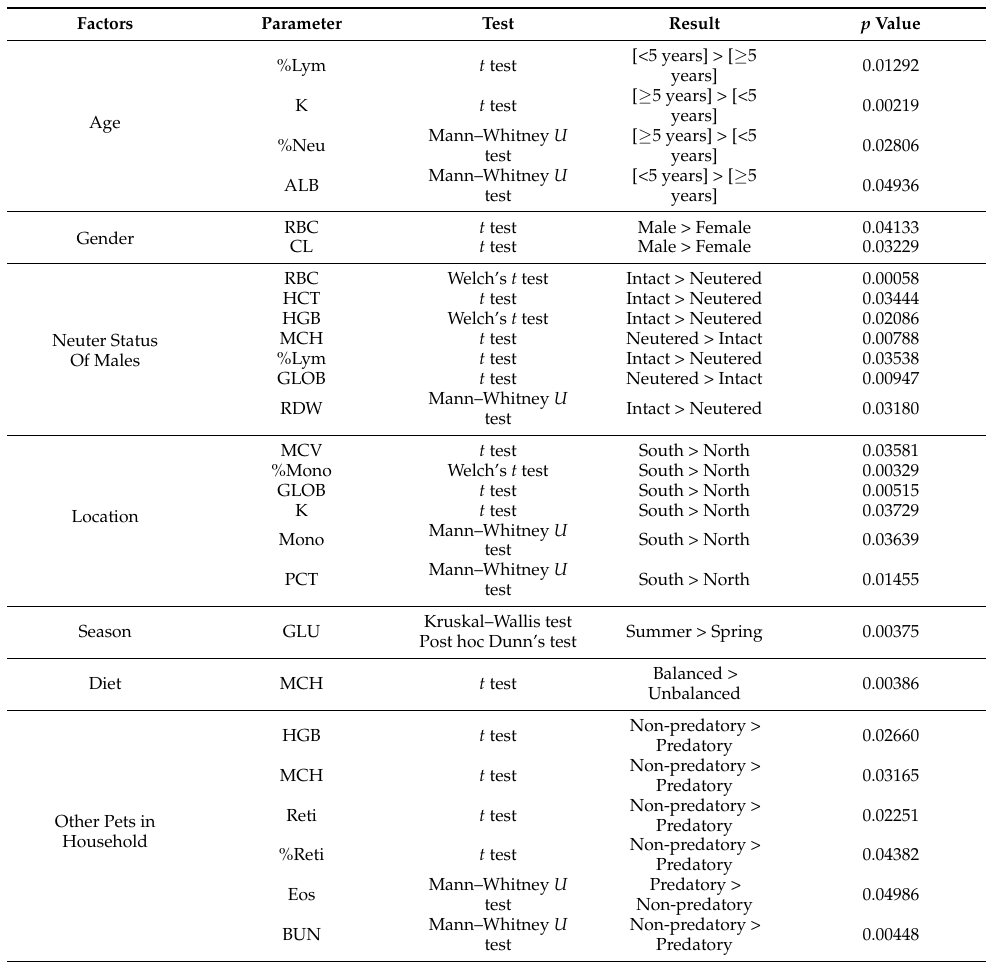
Table 4. Significant statistical test results of univariate analysis on hematological and plasma bio- chemical